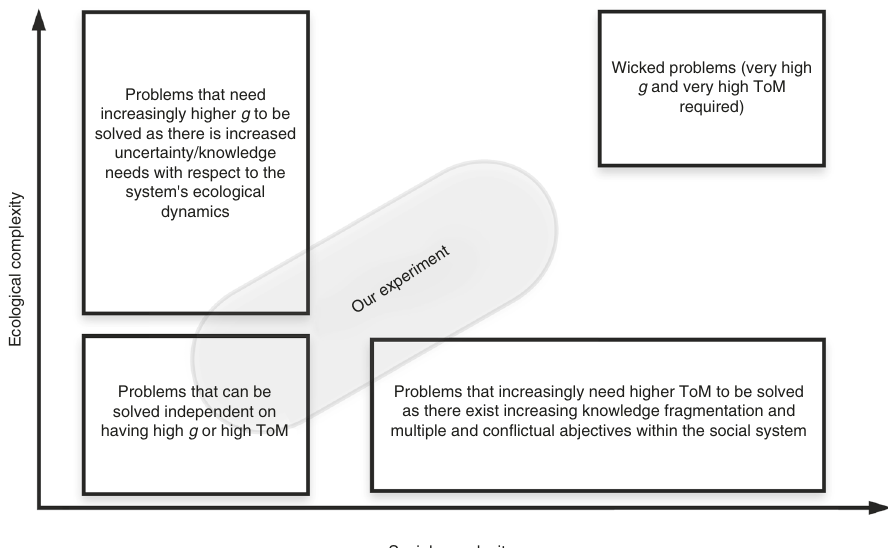
Fig. 5 Relation between ecological complexity, social complexity (including contentiousness of the problem) and relative importance of g and